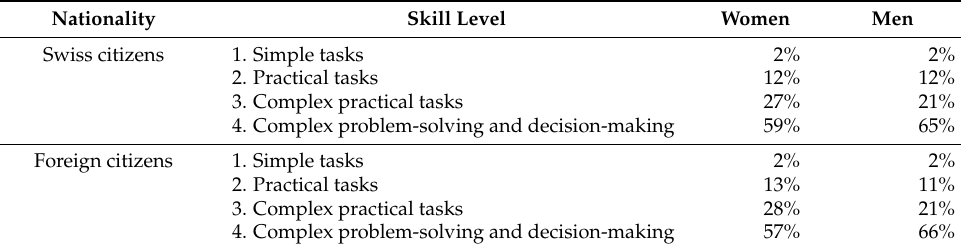
Table 4. Adequacy of Paid Work: Distribution of Employees with Tertiary Education by Nationality, Skill Level, and Gender, Switzerland, 2018.